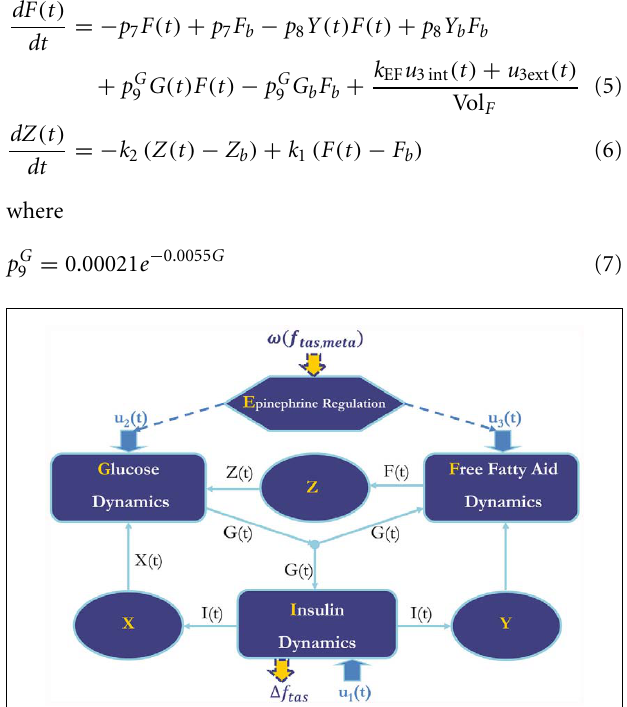
FIGURE 1 | Diagram of metabolic model with epinephrine regulation. X, remote insulin level;Y, remote insulin promotes FFA production and utilization; Z, remote FFA level. (cid:2) f tas , feedback from metabolic system to autonomic control; ω ( f tas,meta ), effect of efferent sympathetic activity and circadian process on metabolic system. u 1 ( t ), u 2 ( t ), and u 3 ( t ): inputs for insulin, glucose, and FFA dynamics,